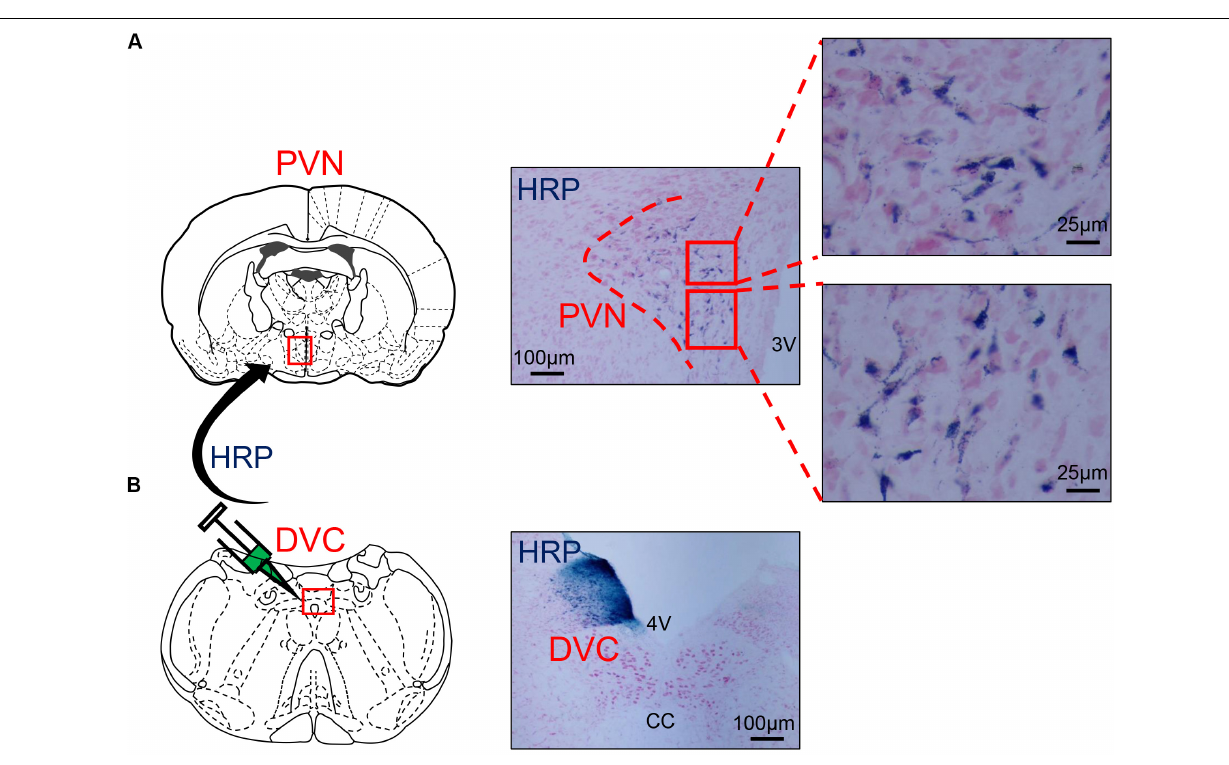
PVN per rat, the following findings were obtained ( Figure 5C ). A total of 634 HRP-labeled neurons in the PVN were